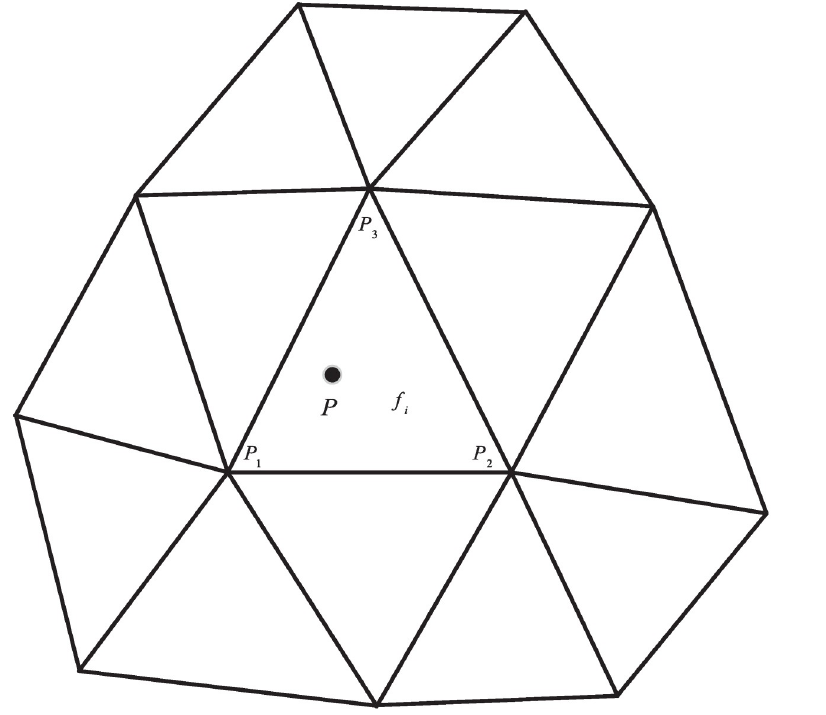
Fig 3. The neighboring triangles of hit point P